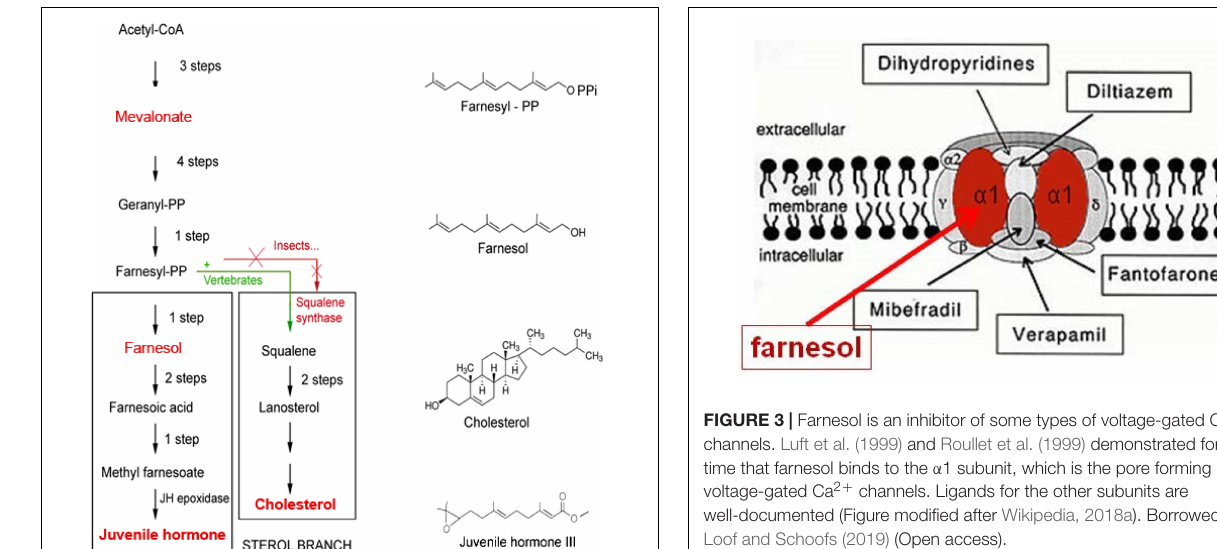
FIGURE 2 | The mevalonate biosynthetic pathway in which farnesol is formed. The initial steps up to the synthesis of farnesyl-PP and farnesol are identical in insects and vertebrates. Later steps are different. Because Ecdysozoa ( = arthropods and nematodes) do not have the gene coding for squalene synthase, they cannot synthesize squalene and cholesterol by themselves. They acquire cholesterol from the food, as a vitamin, or by metabolization of some (ecdy)steroids. Insects can make esters of farnesol, the Juvenile Hormones (JHs), that are more potent than farnesol itself in specific bioassays for JH. Vertebrates do not make JHs, but some plants do. Adapted from Bellés et al. (2005) and De Loof et al. (2014).